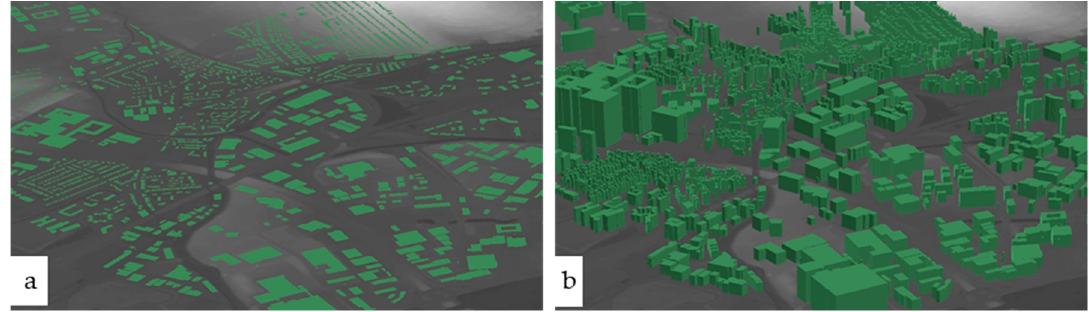
Figure 4. ( a ) 2D building footprints for Nottingham, ( b ) foundation 3D model building footprints generated from AW3D-30 as DSM and GMTED2010 as DTM data.